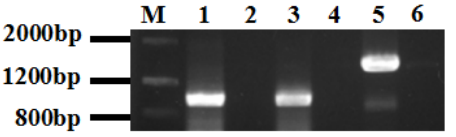
Figure 1. The amplification results of Murrah buffalo PHB, CAPZB, TEKT2 coding sequnence (CDS). PHB, prohibitin; CAPZB, capping actin protein of muscle Z-line beta subunit; TEKT2, tektin-2; PCR, polymerase chain reaction. M, Marker III; 1, PCR product of Murrah buffalo PHB, 948 bp; 3, PCR product of Murrah buffalo CAPZB, 958 bp; 5, PCR product of Murrah buffalo TEKT2, 1,449-bp; 2,4,6, negative control.